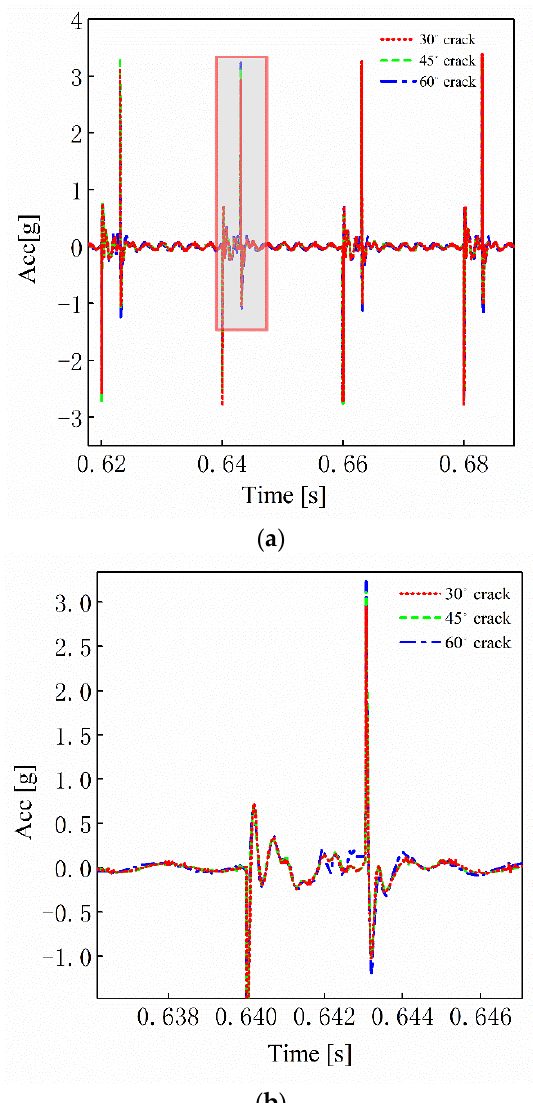
Figure 20. Time ‐ domain diagram of residual error of vibration acceleration at different crack angles. ( a ) The whole. ( b ) Zoomed plot. Figure 21 is the residual signals of vibration acceleration at different crack depths. Red, green and blue lines represent the residual signal of the 1.5 mm depth crack, 2